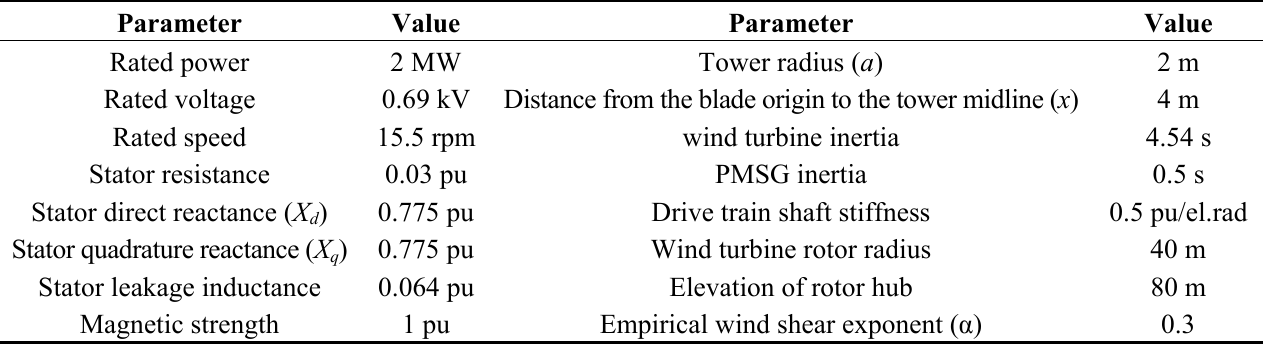
Table A2. The Variable Speed Wind Turbine Parameters with